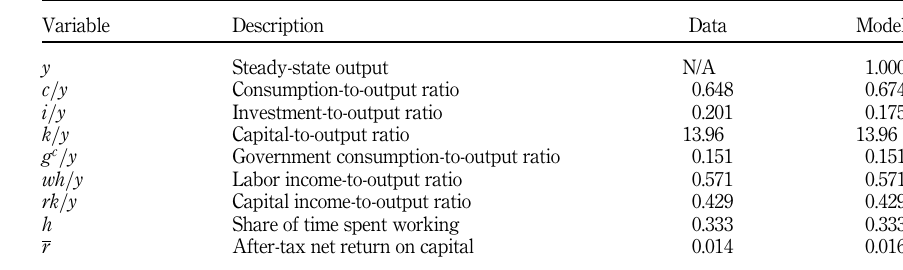
Table 2. Data averages and long-run